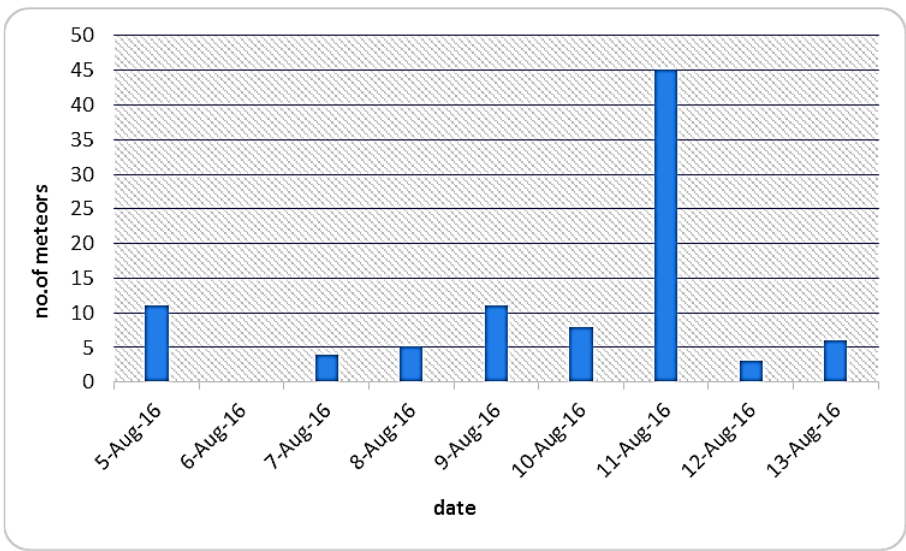
Fig. 1 The distribution of the number of the meteors detected during 5-13 August 2016.